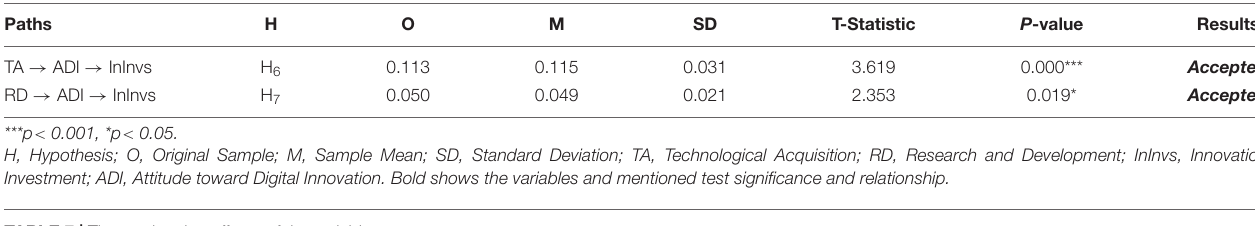
TABLE 7 | The moderating effects of the variable. Paths H